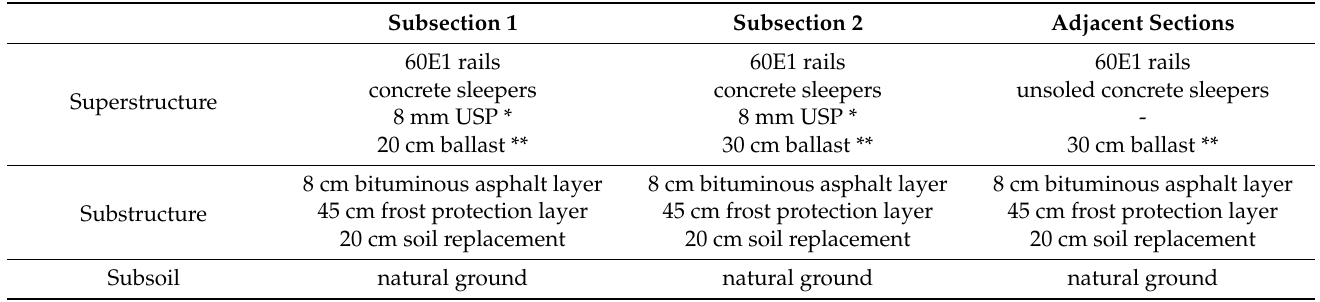
Table 1. Track components of the test sections and the adjacent track.